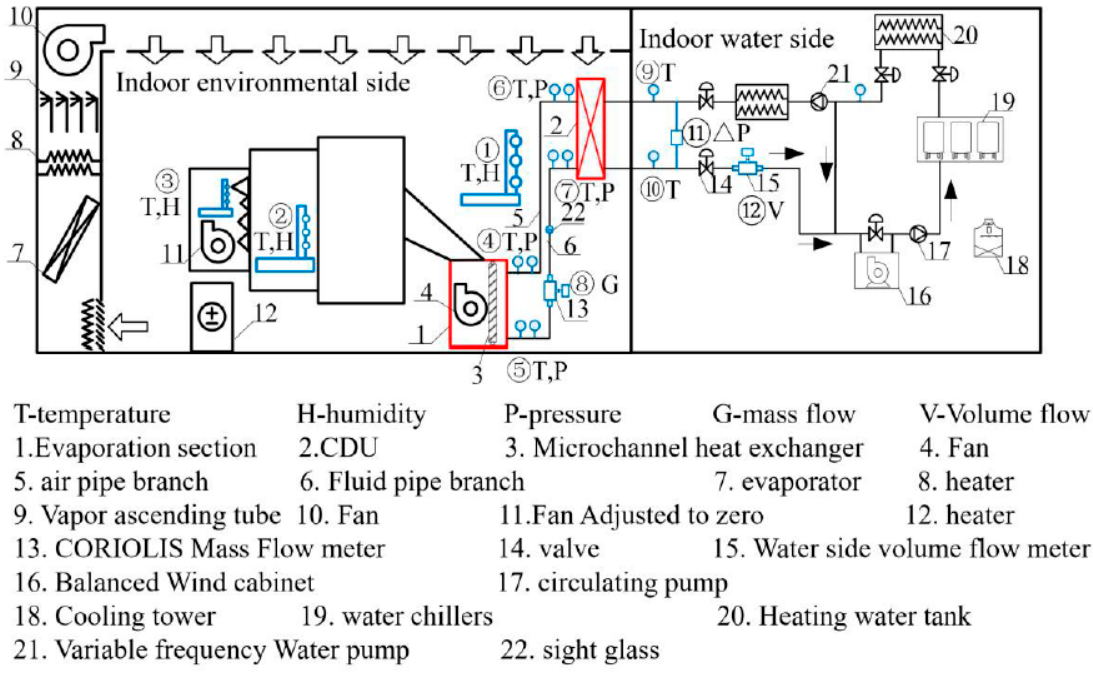
Table 1. Other experimental